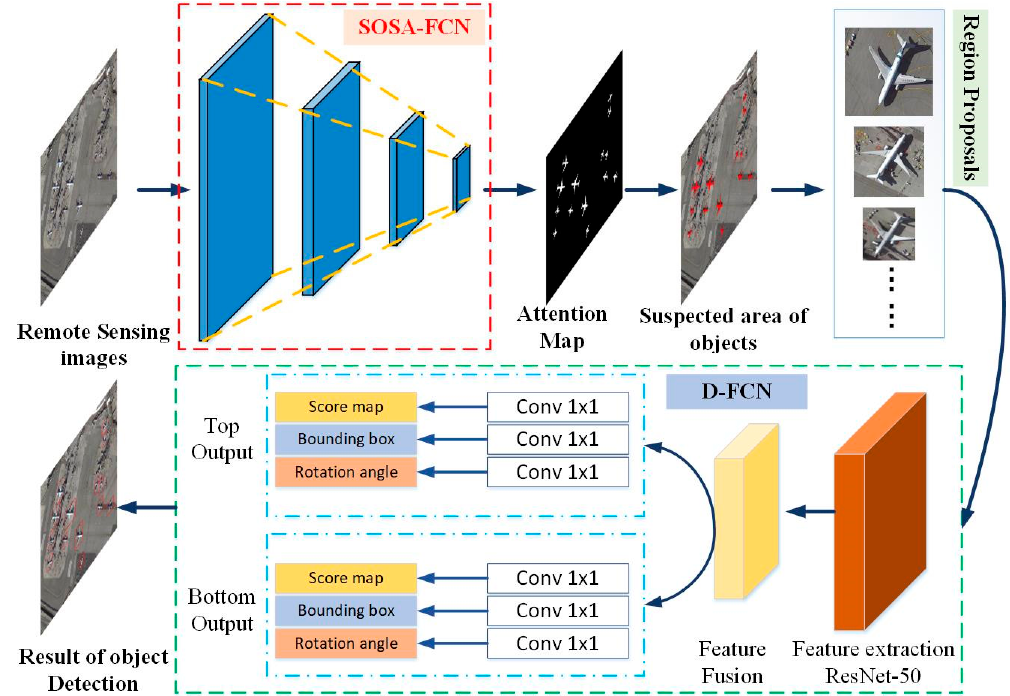
Figure 1. Architecture of our Network. The self-attention pre-screening fully convolutional network (SOSA-FCN) realizes pre-screening as in traditional detection methods by using the method of deep learning. After inputting a large-sized remote sensing image into SOSA-FCN, an attention map containing object location information is obtained. According to the attention map, candidate regions suspected of having objects are obtained. The candidate regions are sent to the accurate detection fully convolutional network (AD-FCN) network for accurate object detection. The task of real-time object detection in high-resolution large-scene remote sensing images is realized by using two cascaded networks.